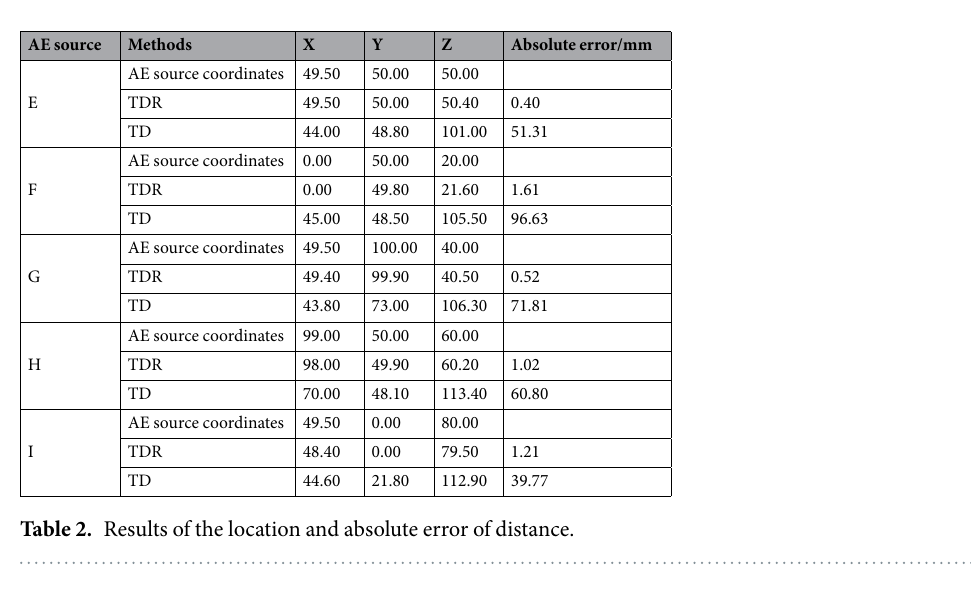
Figure 11. The average absolute errors of the AE sources in the 3D location test.